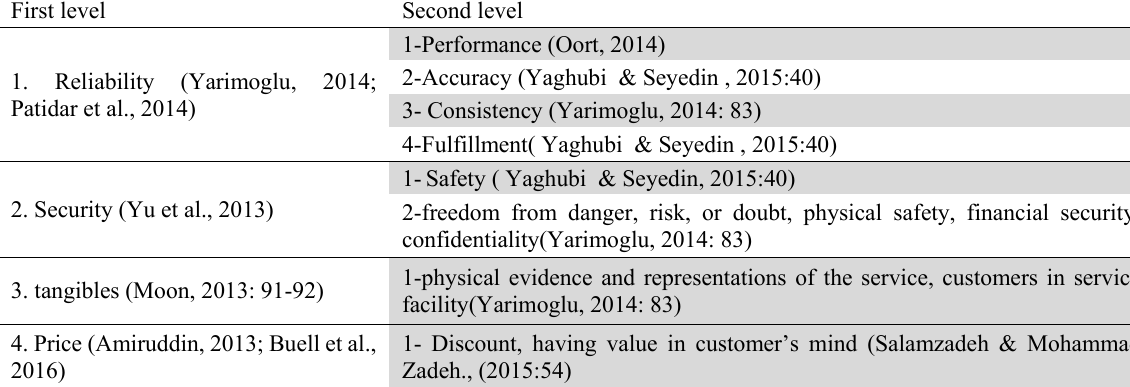
Factors related to the features of service at abstract and concrete